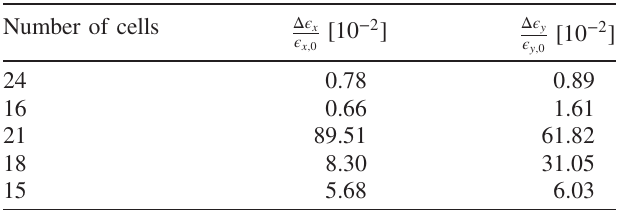
TABLE VIII. Relative emittance growth for regular FODO lattices with different number of cells. In this case the number of cells defines the lattice